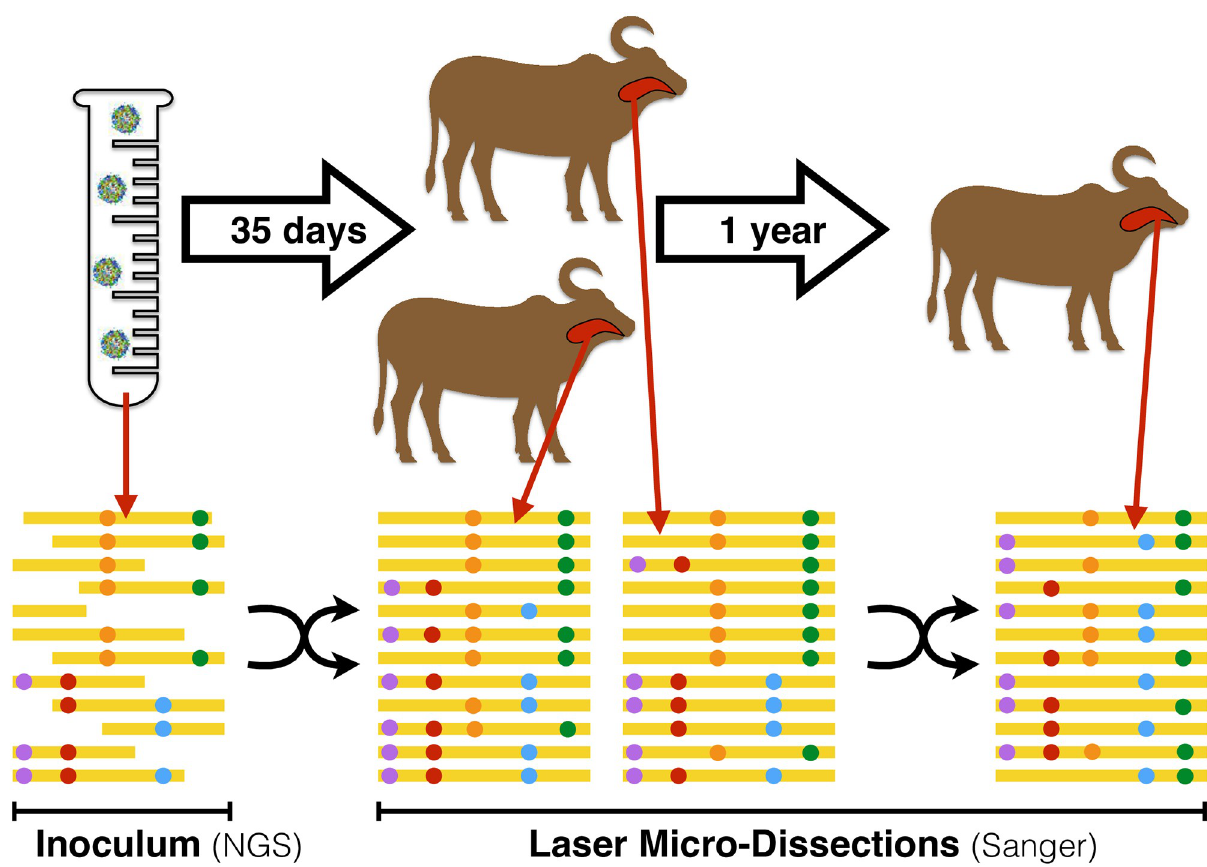
Fig 1. Illustration of the setup for the artificial inoculation and sampling (above) and the sequencing data (below) for the experiment.